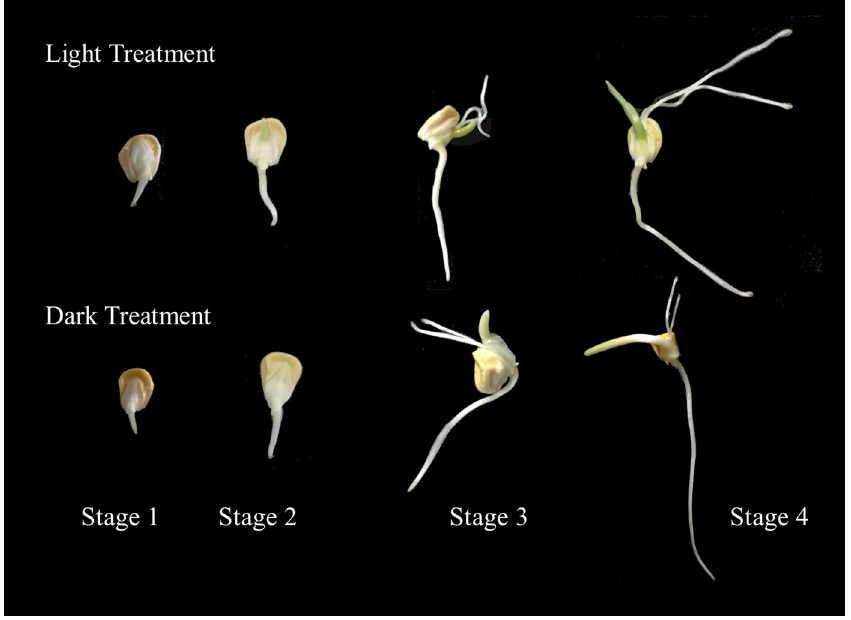
Figure 2. Sweet corn sprouts at different germination stages. Stage 1 representing initial radical emergence (typically after 48 hours); stage 2 representing chitting of the corn (typically after 72 hours); stage 3 representing emergence of the shoot and development of the root (typically after 96 hours); stage 4 representing shoot and root elongation with the appearance of euphylla (typically after 130